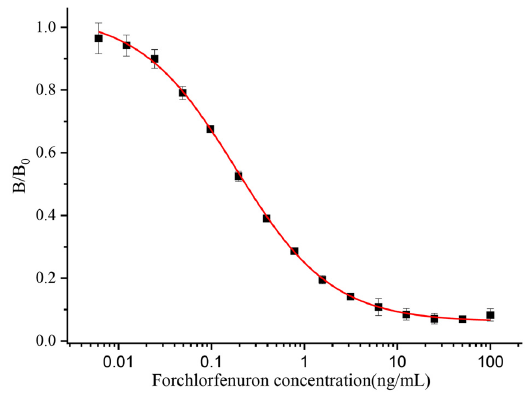
Figure 5. Ic-ELISA curve of CPPU in cucumber samples.